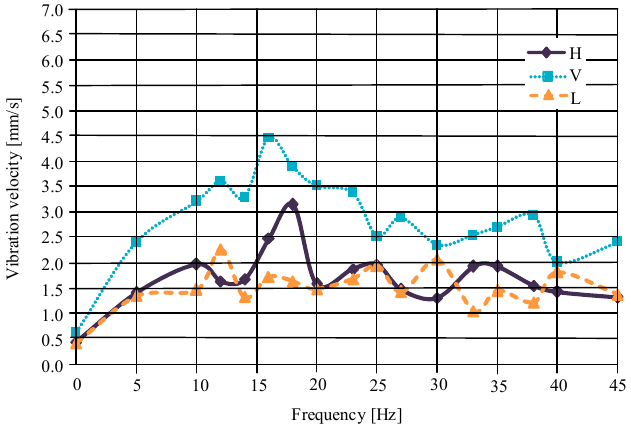
Figure 7. Measured broad-band vibration velocity in the horizontal (H), vertical (V) and longitudinal (L) direction vs. the subharmonic frequency for motor 3 Case A (uncoupled motor).